Question: In one sentence, what is this figure communicating?
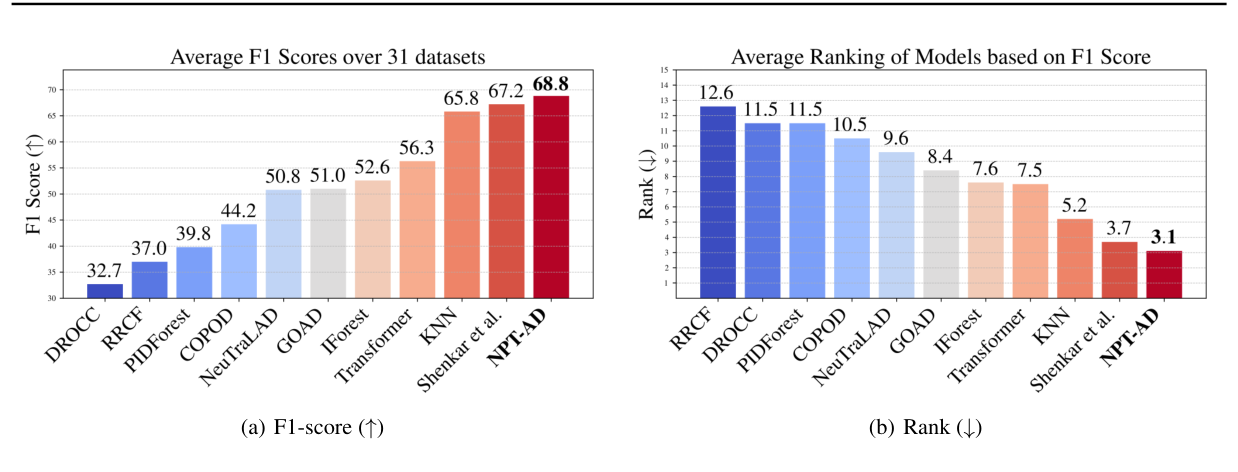
Answer: For each of the 31 datasets on which models were evaluated, we compute the average F1-score over 20 runs for 20 different seeds. We report on figure 2(a) the average F1-score over all datasets for each tested model. We report on figure 2(b) the average rank over the 31 datasets. For both figures, the model displayed on the far left is the worst-performing model for the chosen metric, and on the far right is the best-performing model. We also highlight the metric of the best-performing model in bold. See tables 4 and 5 in appendix D.1 for the details of the obtained metrics.